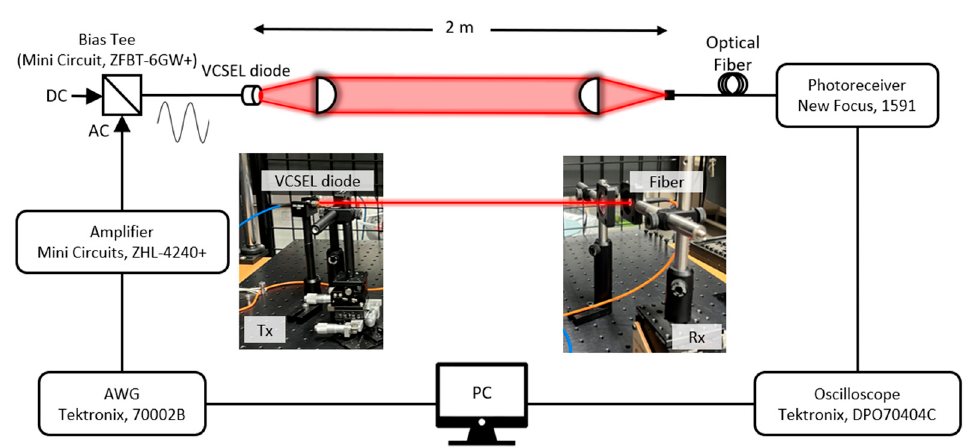
Figure 5. Experimental setup.